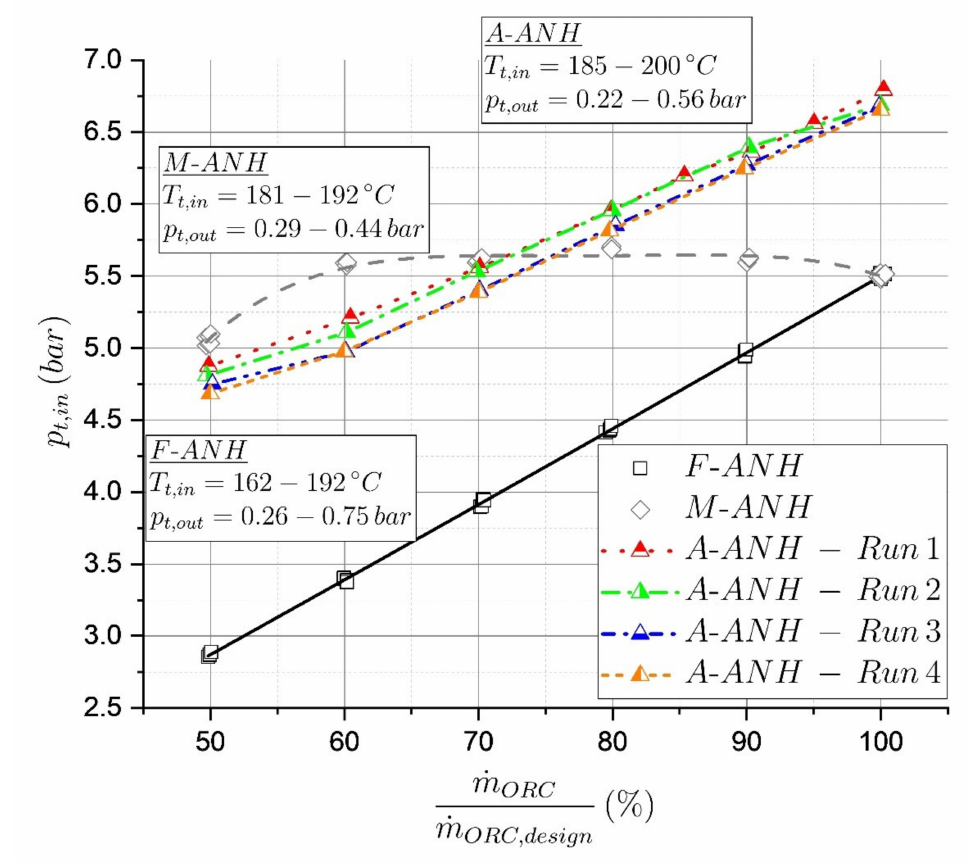
Figure 8. Turbine inlet pressure as a function of the working fluid mass flow